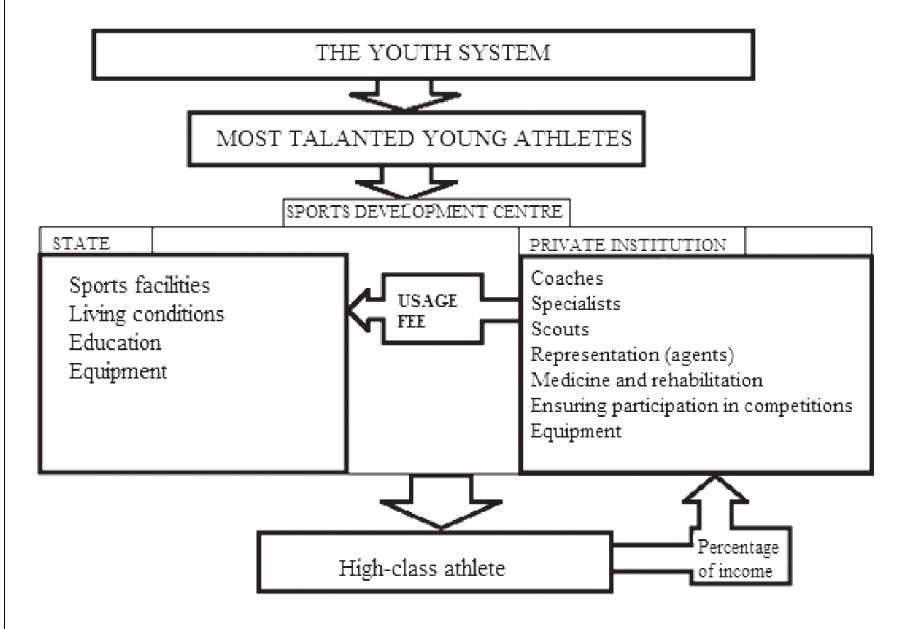
Figure 2. High-achieve - ment sports development centre operation